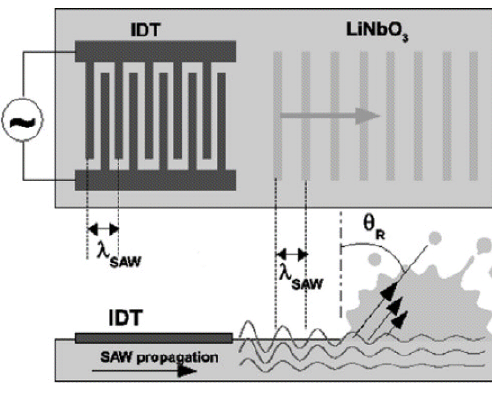
Figure 3. Interdigital Transducer IDT (top) and motion of the SAW in the sagittal plane (right).